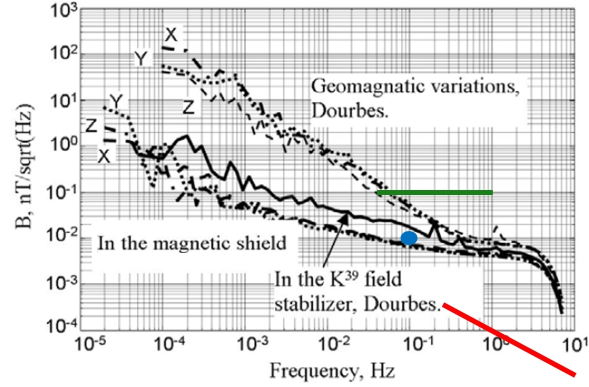
Figure 1. Noise spectra of a magnetometer prototype and of mea- sured natural geomagnetic variations (modified after Korepanov, 2007). We added the high-frequency noise level of the FGE mag- netometer as measured at NGK (green line) and the high-frequency noise of a typical induction coil magnetometer (red line). The blue dot shows the specification required by the INTERMAGNET definitive 1s data standard (Turbitt,